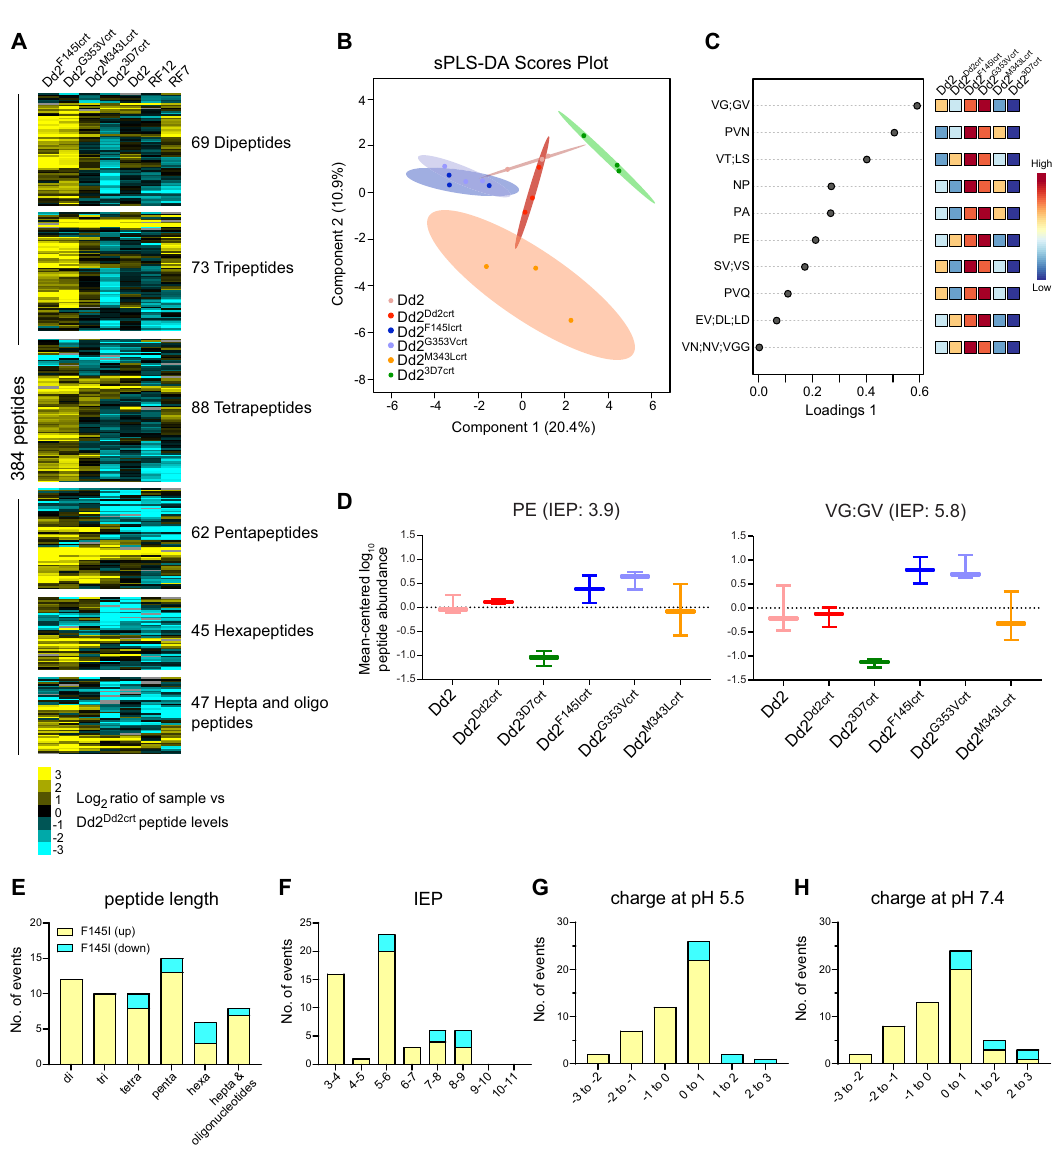
Fig 3. PPQ-resistant and PPQ-sensitive parasites differ in their intracellular repertoire of hemoglobin-derived peptides. (A) Heatmap of 384 peptides (detected in both modes and present in at least 6 out of 7 parasite lines), classified by peptide lengths, showing differences in the accumulation of peptides computed from log 2 fold changes in the average abundance of each peptide identified from each line compared to Dd2 Dd2crt (N, n = 3, 3). Hepta and oligo refers to peptides � 7 amino acids in length. (B) sparse Partial least- squares discriminant analysis (sPLS-DA) of mean-centered log 10 -transformed peptide abundance, showing that parasite lines cluster as groups separated by their CQ and PPQ phenotypes. Points represent individual sample replicates while the 95% confidence interval is represented by the shaded region. (C) Plot showing the top 10 variables selected by the sPLS-DA model for Component 1 (listed as Loadings 1). The variables are ranked by the absolute values of their loadings. Heat maps represent the relative abundance of each metabolite, with red and blue showing high and low levels, respectively. (D) Box and whisker plots showing mean-centered log 10 abundance of select peptides that show a significant difference between the two PPQ-R Dd2 F145Icrt and Dd2 G353Vcrt lines and the others. ( E-H ) Characteristics of peptides whose abundance differs significantly between Dd2 F145Icrt and Dd2 Dd2crt . Differences are shown for ( E ) peptide lengths, ( F ) isoelectric points (IEP), ( G ) peptide charge at pH 5.5, and ( H ) peptide charge at pH 7.4. Details are provided in S4 Table , which also lists Dd2 G353Vcrt and Dd2 M343Lcrt each vs. Dd2 Dd2crt